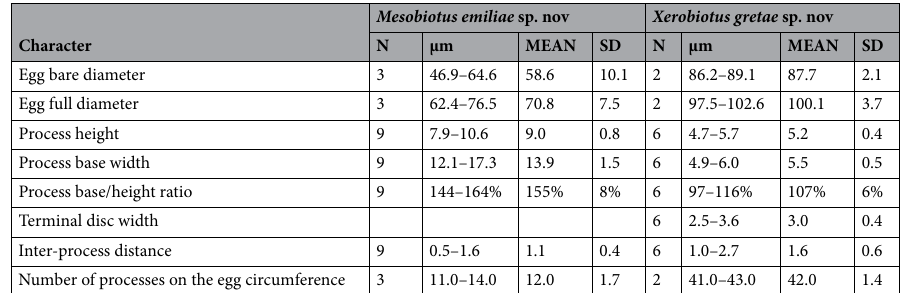
Table 1. Summary of the morphometric data of the animals of the species new to science. Within the table the number of specimens measured for each species (for the number of measurements for each character see Supplementary Table S1), the measures of the selected structures (characters; range in µm), and the relative pt indexes are displayed.